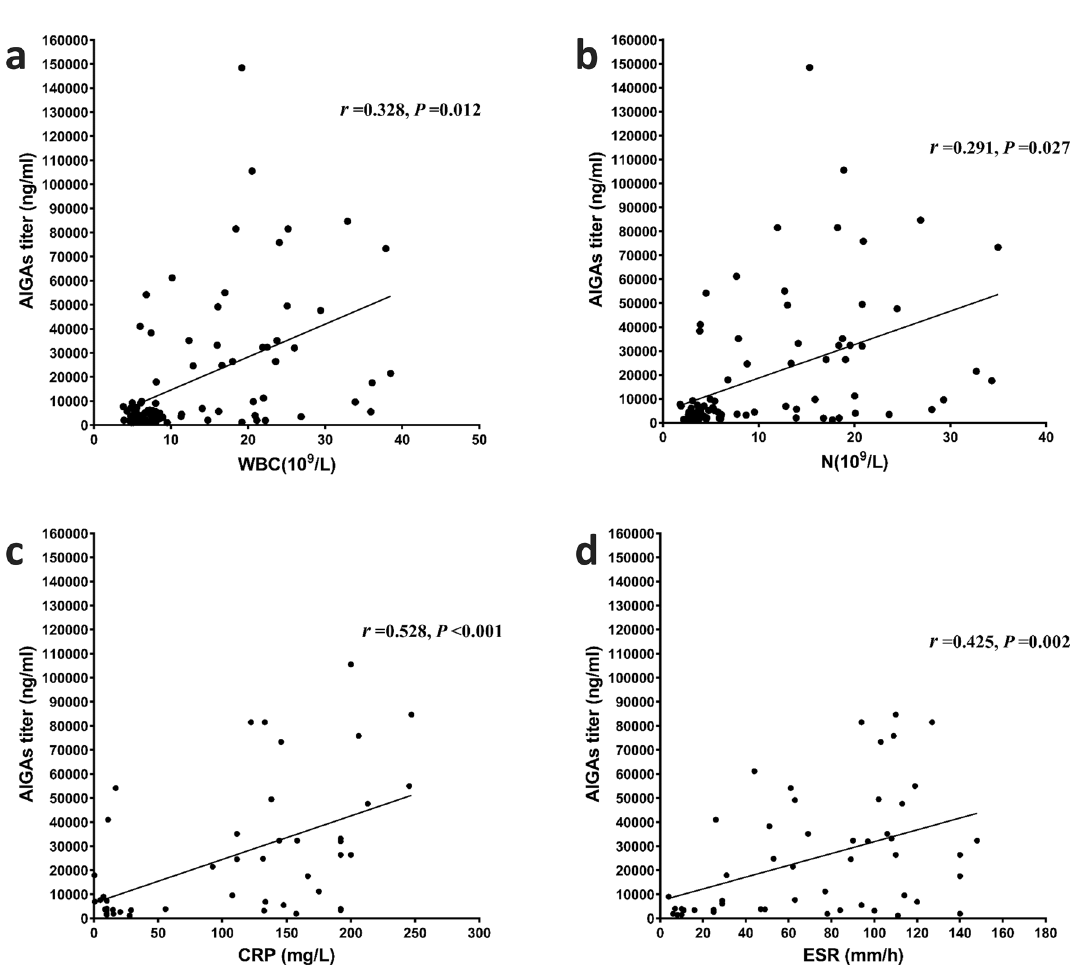
Figure 2. Pearson correlation analysis between anti-IFN-γ autoantibodies and inflammatory markers. WBC ( a ), N ( b ), CRP ( c ), and ESR ( d ). P < 0.05. AIGA anti-IFN-γ autoantibody; WBC white blood cell; N neutrophil count; ESR erythrocyte sedimentation rate; CRP C-reactive